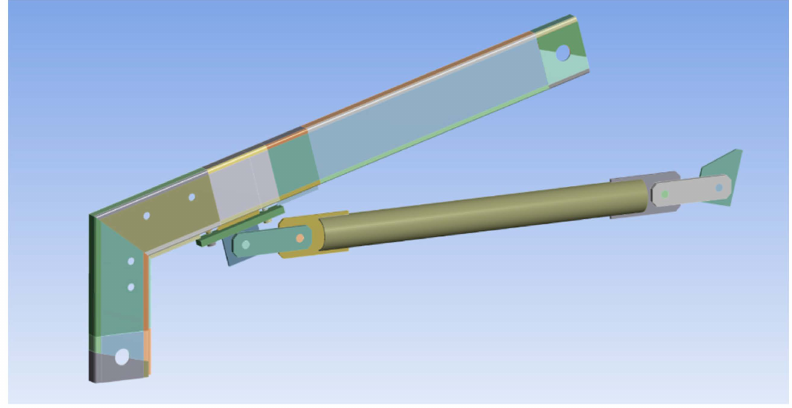
Figure 12. Numerical model (3D view).